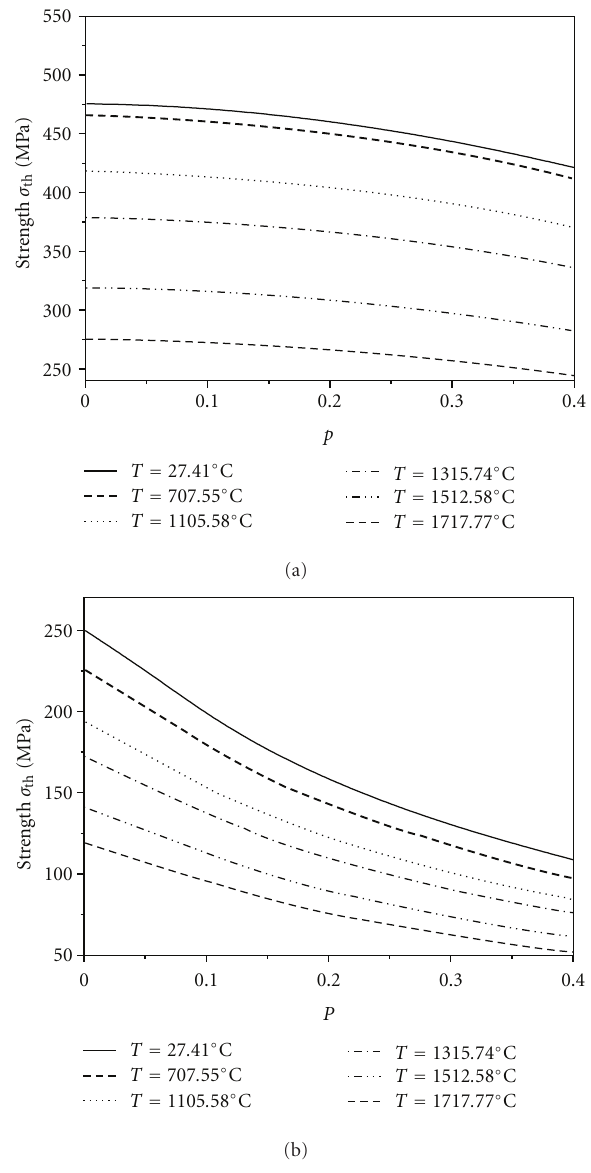
Figure 5: (a) SiC particle volume fraction dependence of material strength at di ff erent temperatures ( R = 15 μ m, s/R = 0 . 001). (b) SiC particle volume fraction dependence of material strength at di ff erent temperatures ( R = 15 μ m, s/R =